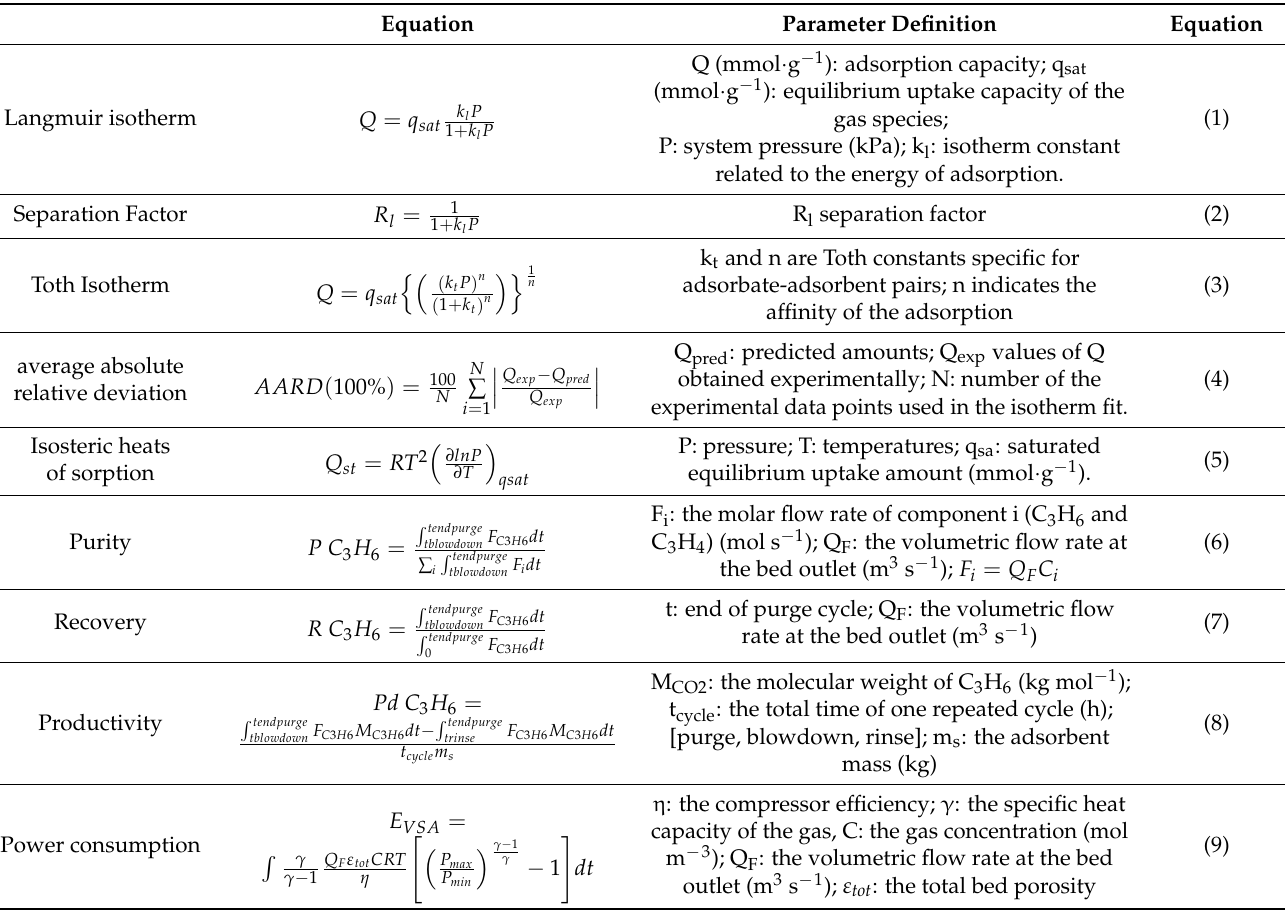
Table 3. Mathematical expressions used for the representation of experimental data.